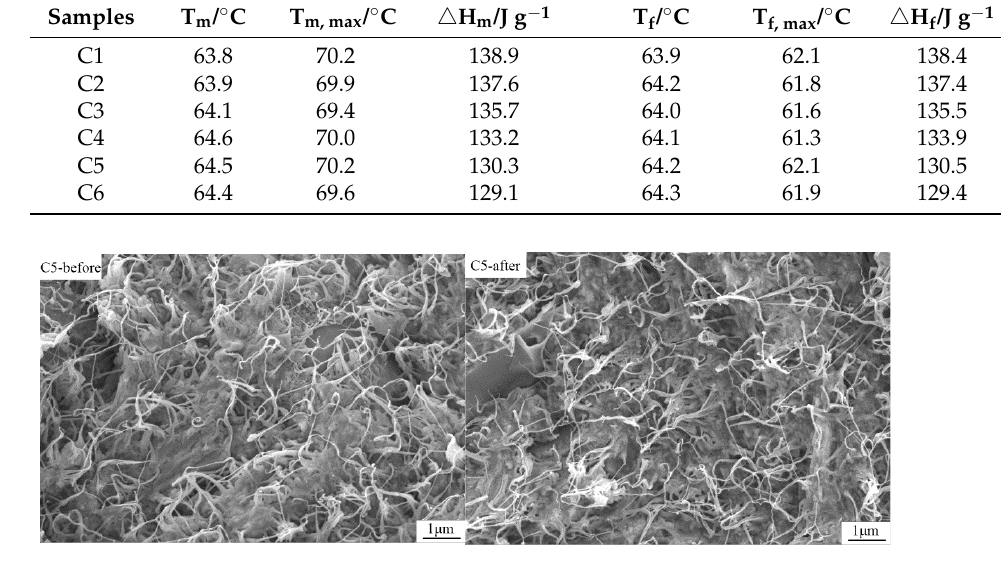
Figure 9. Melting−freezing properties of CNT -PE-EPDM/EG-based PCM sample C5 before and after 200 cycles. 3.7. Photo-Thermal Conversion Performance of CNT/PE-EPDM/EG Phase Change Materials The photo-thermal conversion performance and receiver efficiency of the as-pre- pared CNT-PE-EPDM/EG composite PCMs are shown in Figure 10. It can be found that the temperature plateau in the range 65~70 ℃ appears in the both heating and cooling process, showing the typical characteristics of the temperature-time curve of phase change materials. The time for sample C1 to increase from room temperature to 98.3 ℃ is 274 s, while the times for sample C2 to C6 are 237, 211, 195, 166 and 163 s, respectively. From sample C1 to C6, the temperature rise time is reduced by 40%. These results indicate that the temperature growth rate is positively correlated with the increasing thermal conduc- tivity. The receiver efficiency is calculated according to Equation (1). The calculated re- ceiver efficiencies are shown in Figure 10B. It is shown that the receiver efficiency of all samples presents a downward trend with the raise in temperature. This is mainly because the higher temperature, the more heat flows into the atmosphere. The receiver efficiency of sample C1 decreases from 70% to 50% as the temperature rises from 30 to 90 ℃ . The receiver efficiency from sample C1 to C6 increases, in turn, under the same receiver tem- perature. The receiver efficiency of sample C5 decreases from 87% to 74% at as the tem- perature, rising from 30 to 90 ℃ . The receiver efficiency of sample C6 reaches 88% at 30 ℃ and over 80% at 90 ℃ . These results demonstrate that high thermal conductivity in CNT/PE-EPDM/EG phase change material is beneficial for the rapid storage of photo ther- mal conversion energy, and is thus conducive to the improvement of the receiver effi- ciency of phase change material.